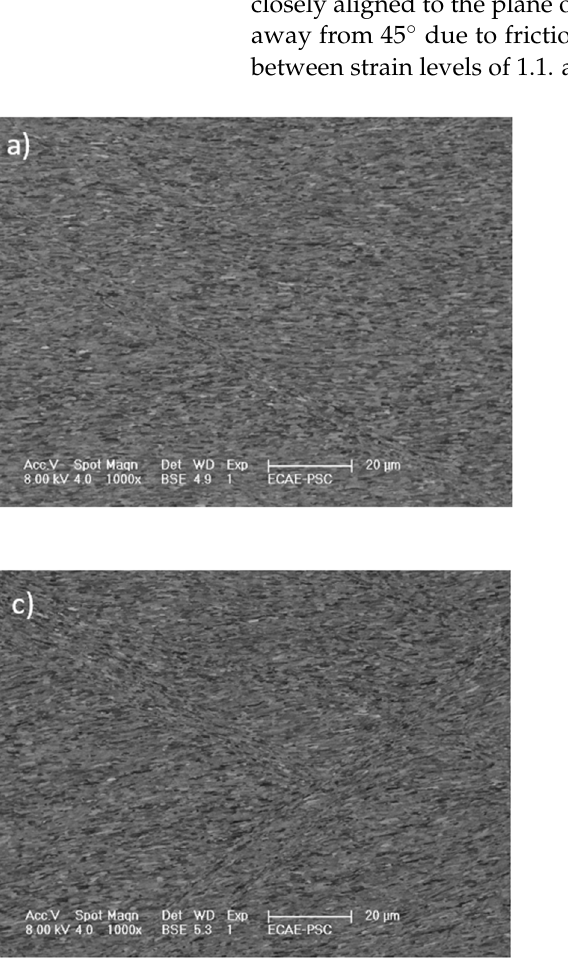
Figure 2. EBS images showing the UFG structures on the TD plane developed during PSC at room temperature to a true strain of 1.1 ( a , b ) and 2.1 ( c , d ), following 15 passes ECAE. The compression direction is vertically aligned.